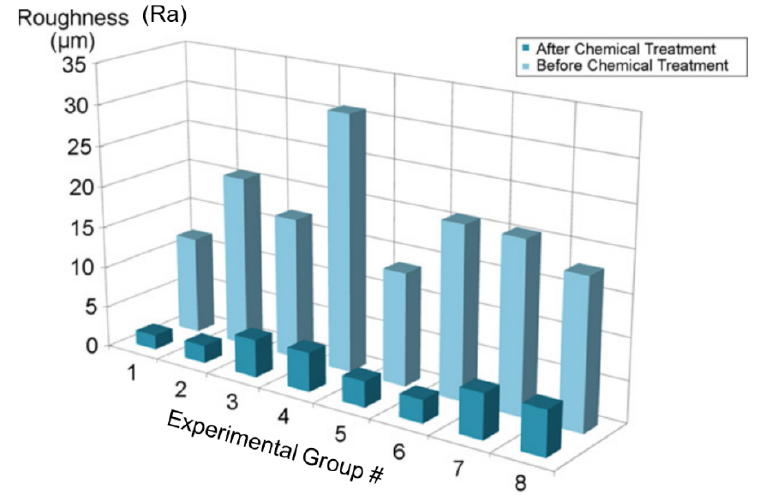
Figure 10. Surface finish improvement after chemical treatment [21].